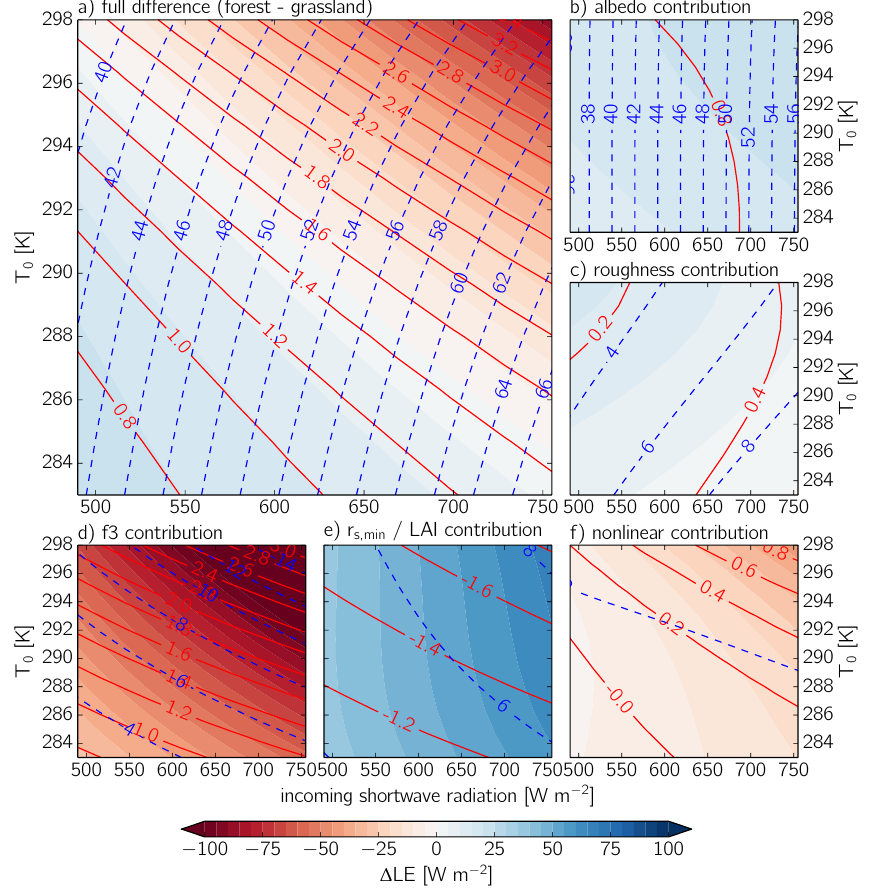
Figure 7. Difference in evapotranspiration (color band), maximum temperature (red solid line) and net radiation (blue dashed line) between forest and grassland as a function of initial temperature and incoming shortwave radiation. Small panels indicate the contribution of indi- vidual processes/parameters, such that a = b + c + d + e + f . The value f is acquired by subtracting b + c + d + e from a . The values for evapotranspiration and net radiation are the 10h means over the entire duration of the model run, and the maximum 2m temperature is the maximum over the entire